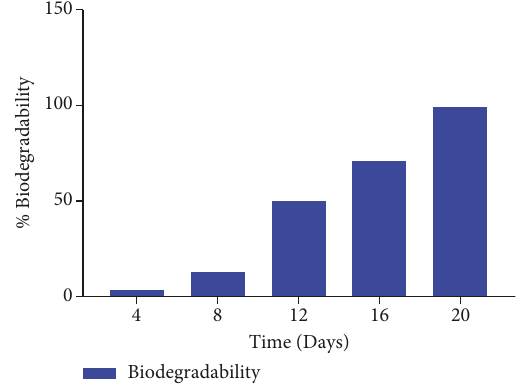
Figure 6: % Biodegradability of the biopolymer with respect to time.